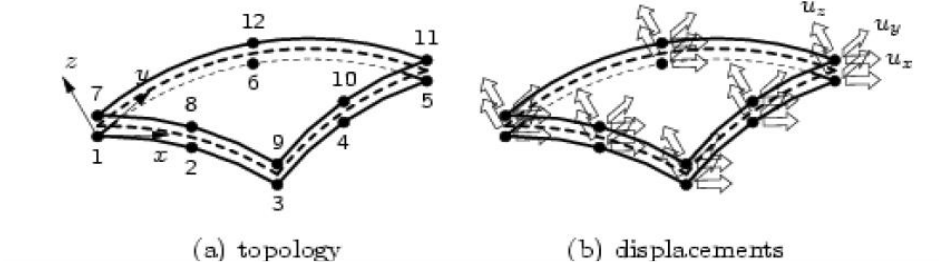
Fig. 4. Shcematic of Surface interface elements for solid to solid elements connection